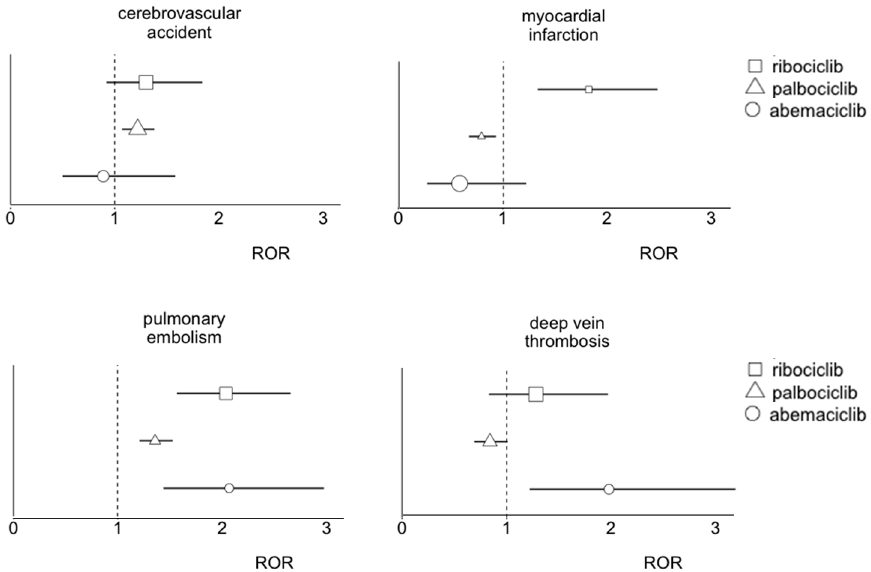
Figure 1. Consolidated disproportionality for selected thromboembolic events. The size of the ROR estimates is proportional to the number of cases.